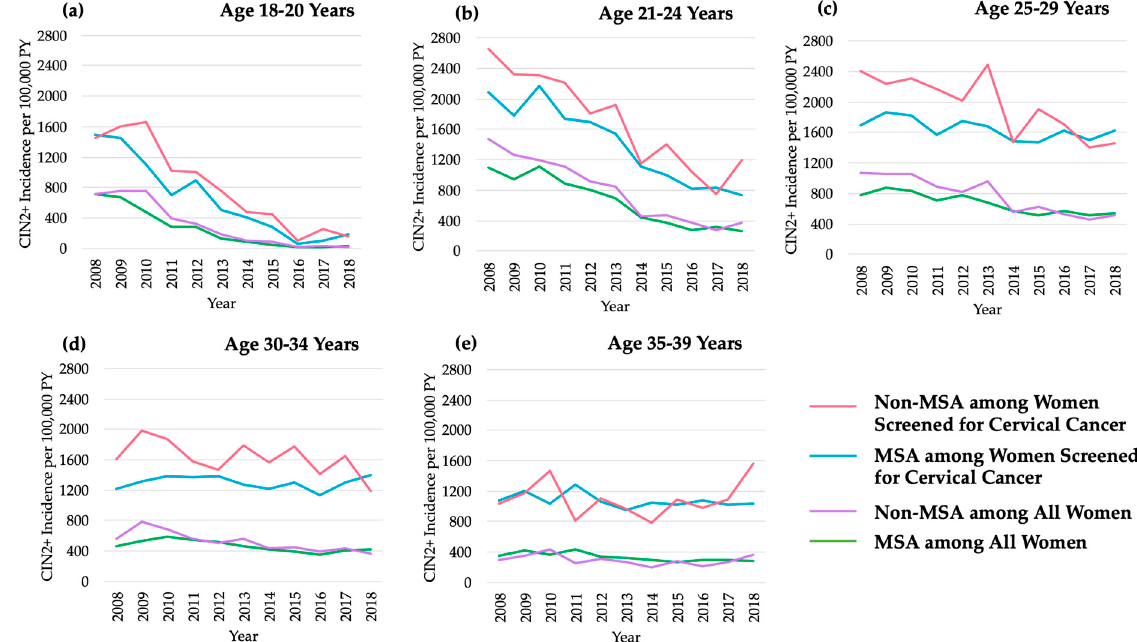
Figure 1. Annual CIN2+ incidence per 100,000 person-years among all women enrolled in Tennessee Medicaid and the subset of women screened for cervical cancer who resided in MSAs versus non-MSAs aged: ( a ) 18–20 years; ( b ) 21–24 carcinoma in situ; MSA: metropolitan statistical area; PY: person-years.